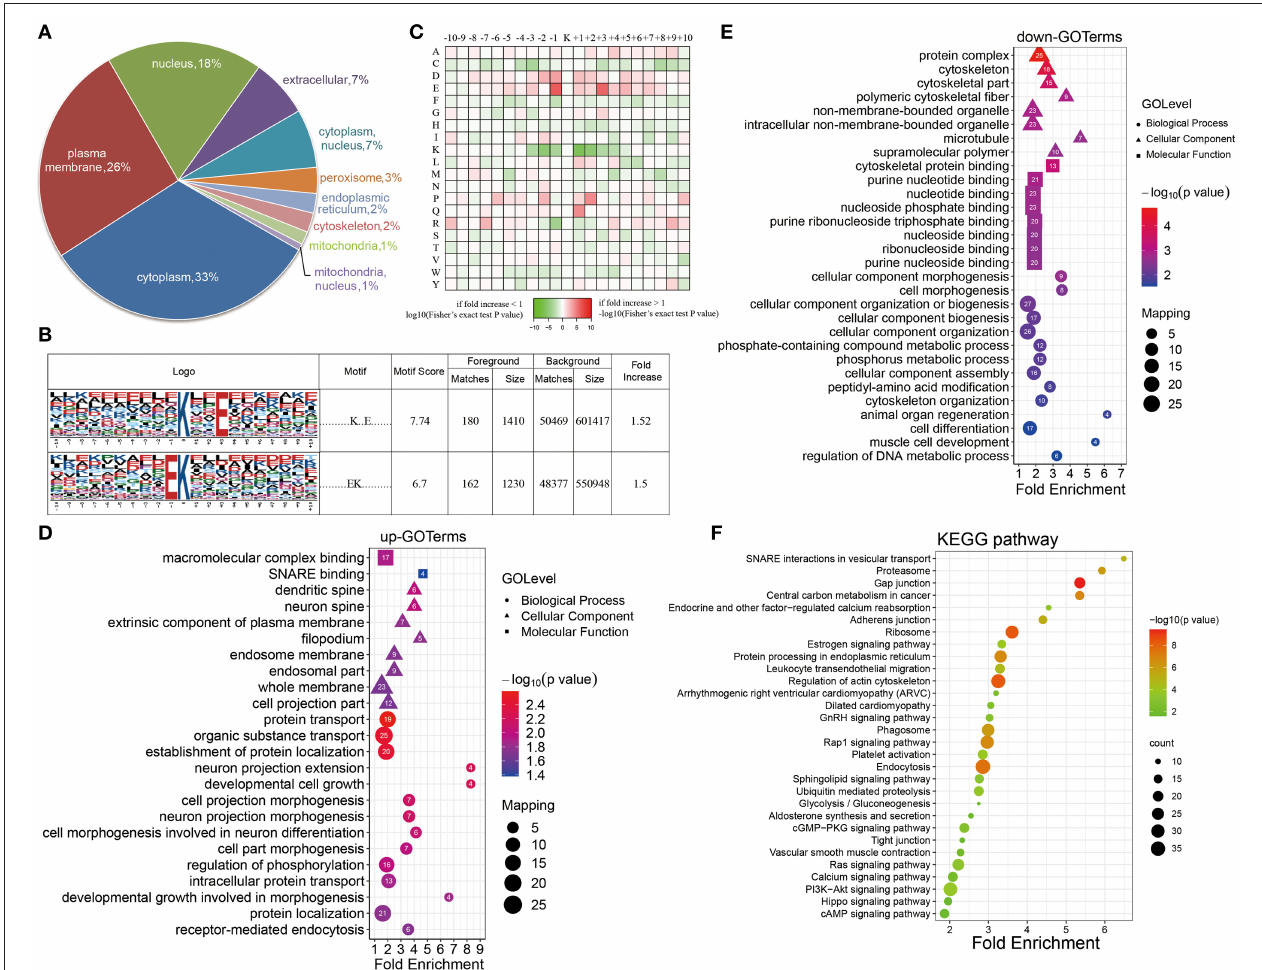
FIGURE 4 | Properties of the quantified ubiquitylome. (A) The subcellular localization of the differentially ubiquitination-modified proteins. (B) Ubiquitination motifs and the conservation of the ubiquitinated sites. (C) A heat map of the amino acid compositions of the lysine ubiquitination sites shows the frequency of different types of amino acids around the ubiquitinated lysine. (D,E) GO-based enrichment analysis of proteins with upregulated (D) and downregulated (E) ubiquitination sites. (F) KEGG pathway